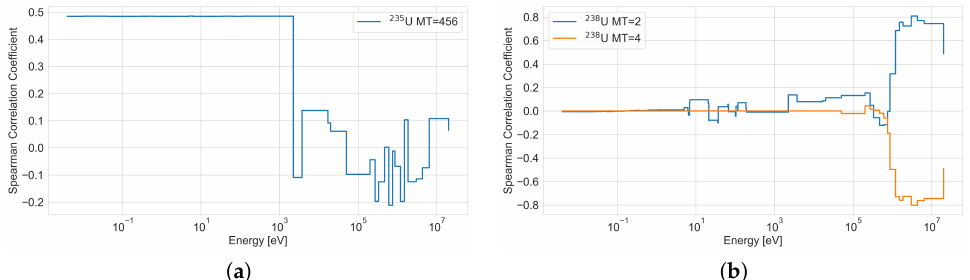
Figure 15. Statistically significant cross-sections Spearman correlation coefficients for ( a ) k eff and ( b ) P max . lin